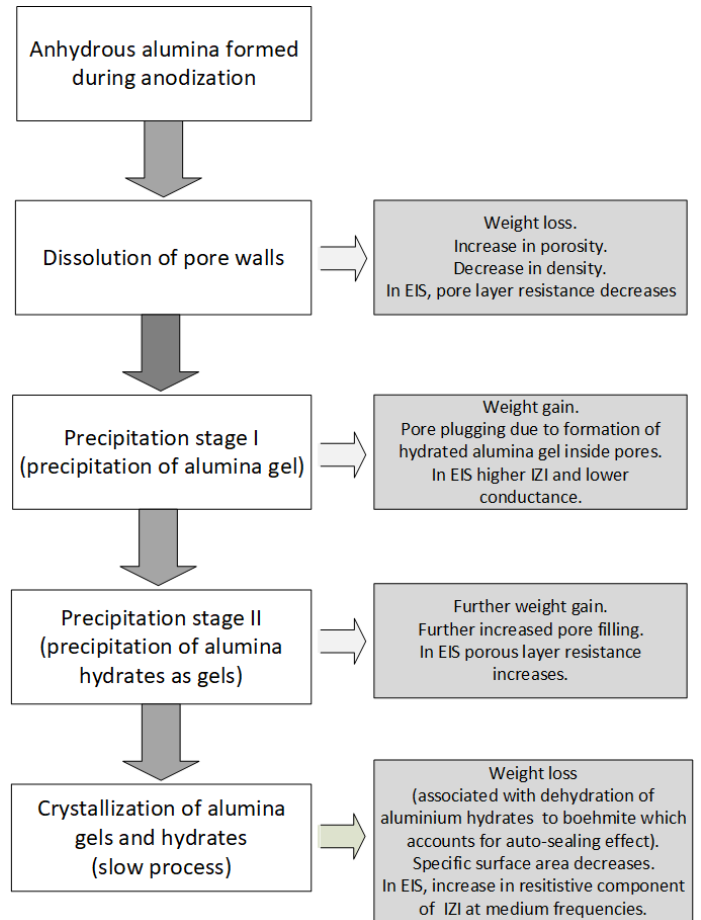
Figure 6. Flowchart of changes that occur during the Sealing Step and Its Exploitation to Monitor Sealing Process and Seal Quality, based on deductions from Refs [170,179,180].